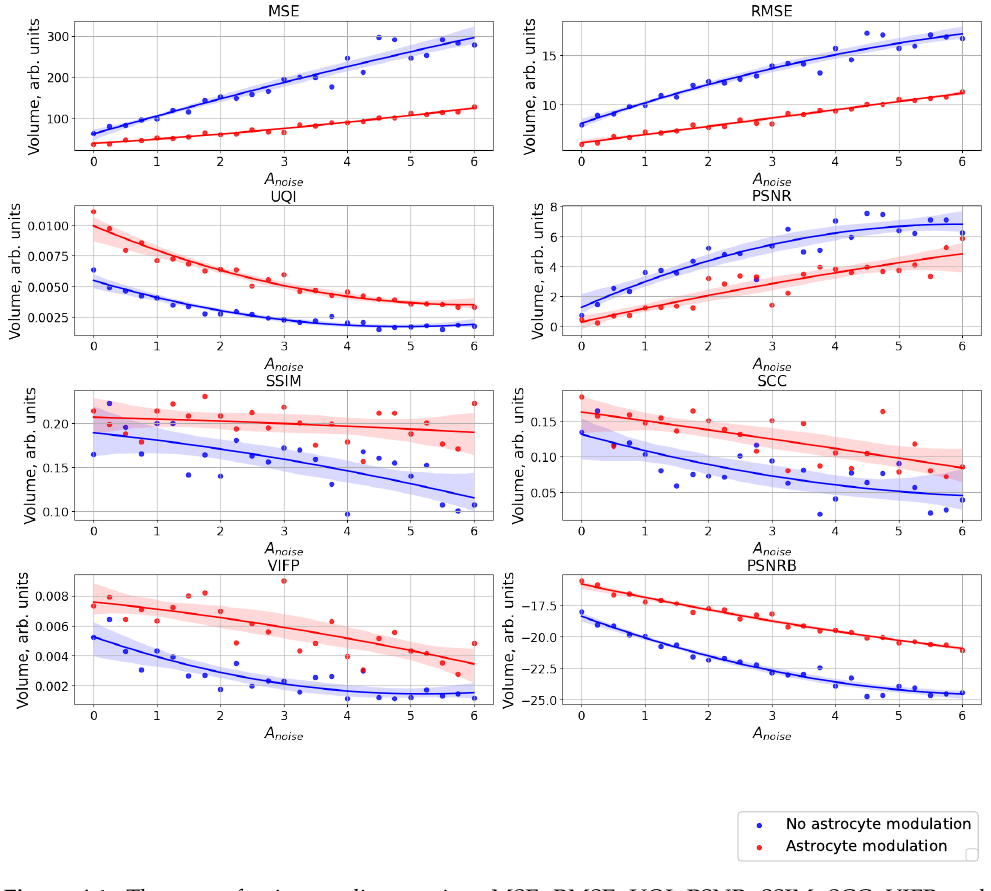
Figure A4. The case of using quality metrics—MSE, RMSE, UQI, PSNR, SSIM, SCC, VIFP, and PSNRB—for comparing raster diagrams of neural activity from Figures A2 and A3 with an image (middle panel of Figure A1) fed to a spiking neural network with an increase in the amplitude, A noise , of the noise signal from 0 to 6 supplied to the neurons of the neural network without astrocytic modulation (blue dots and curve) and with astrocytic modulation (red dots and